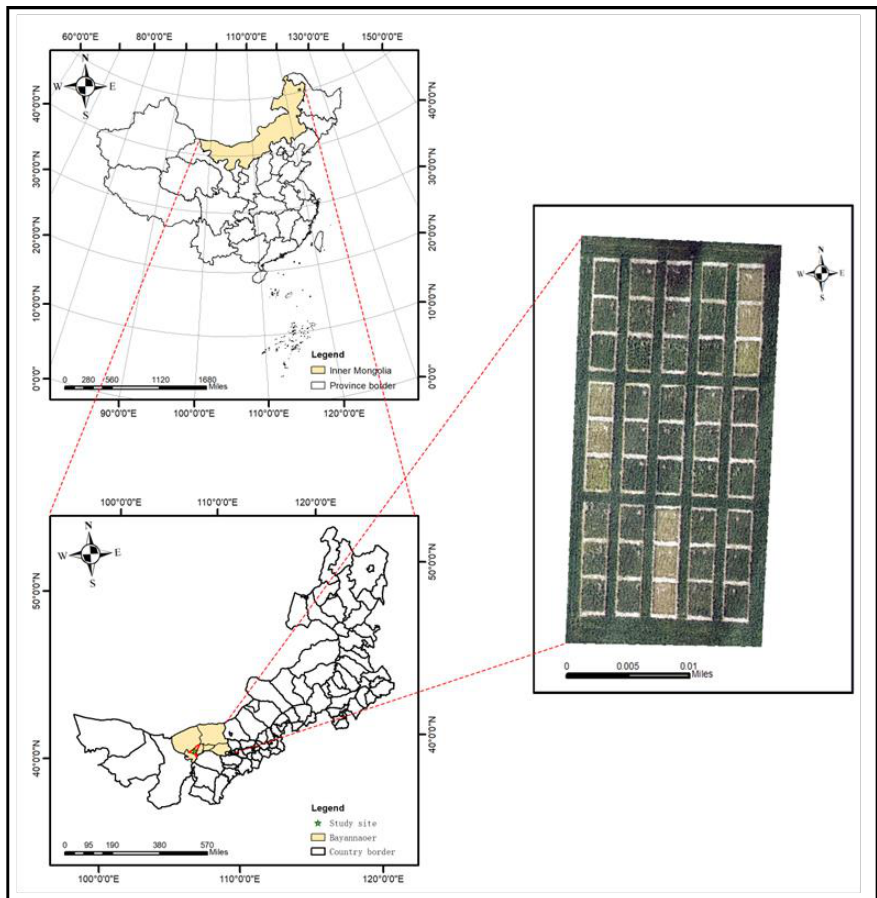
Figure 1. Geographical location of the experimental site. Table 1. Soil base fertility information of the experimental site.